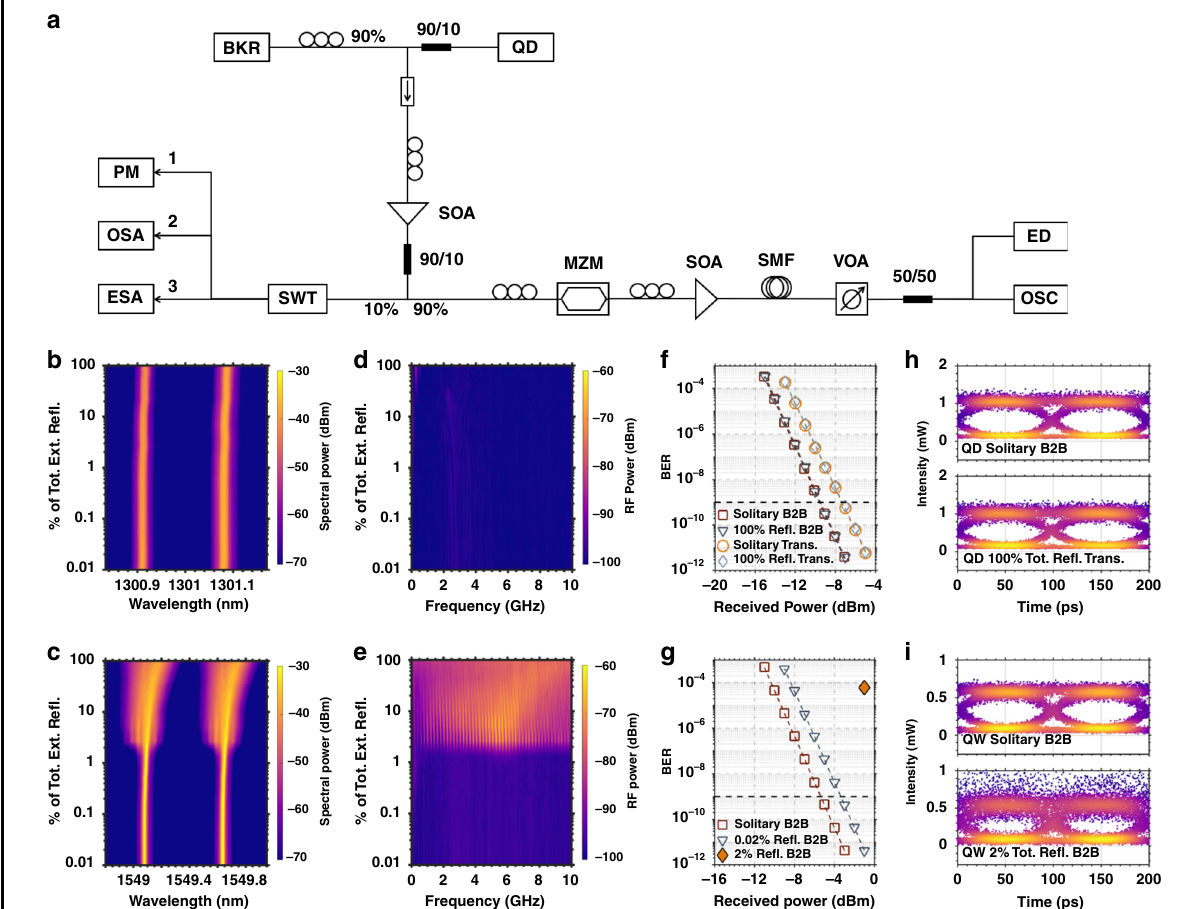
Fig. 9 Re fl ection sensitivity and test-bed experiments. ( a ) Schematic of the optical feedback experimental setup. BKR backre fl ector, SOA semiconductor optical ampli fi er, SWT switch, PM power meter, OSA optical spectrum analyzer, ESA electrical spectrum analyzer, MZM Mach-Zehnder modulator, SMF single-mode fi ber, VOA variable optical attenuator, ED error detector, OSC oscilloscope. Optical mappings as a function of the feedback strength at 3× I th for QD laser ( b ) and QW laser ( c ). RF spectral mappings as a function of the feedback strength at 3× I th for QD laser ( d ) and QW laser ( e ). ( f ) BER curves for solitary QD laser in the back-to-back con fi guration and QD laser with 100% of total external re fl ection in the back-to- back con fi guration, solitary QD laser after transmission and QD laser with 100% of total external re fl ection after transmission. ( g ) BER curves for solitary QW laser in the back-to-back con fi guration and QW laser with 0.02% of total external re fl ection. The orange triangle marker indicates the BER value with 2% of total external re fl ection. ( h ) eye-diagrams for solitary QD laser in the back-to-back con fi guration and QD laser with 100% of total external re fl ection after transmission. ( i ) eye-diagrams for solitary QW laser in the back-to-back con fi guration and QW laser with 2% of total external re fl